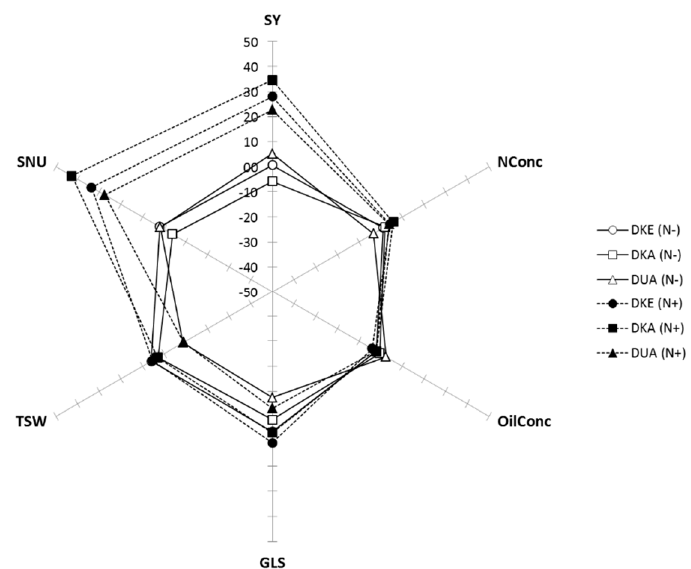
Figure 4. Comparison of yield and harvest quality parameters. The spider plot shows the percentage variation of the normalized trait values relative to the average of the unfertilized plots (0% indicates no difference compared to the average of N − plots). Parameters are de fi ned in Table 1.